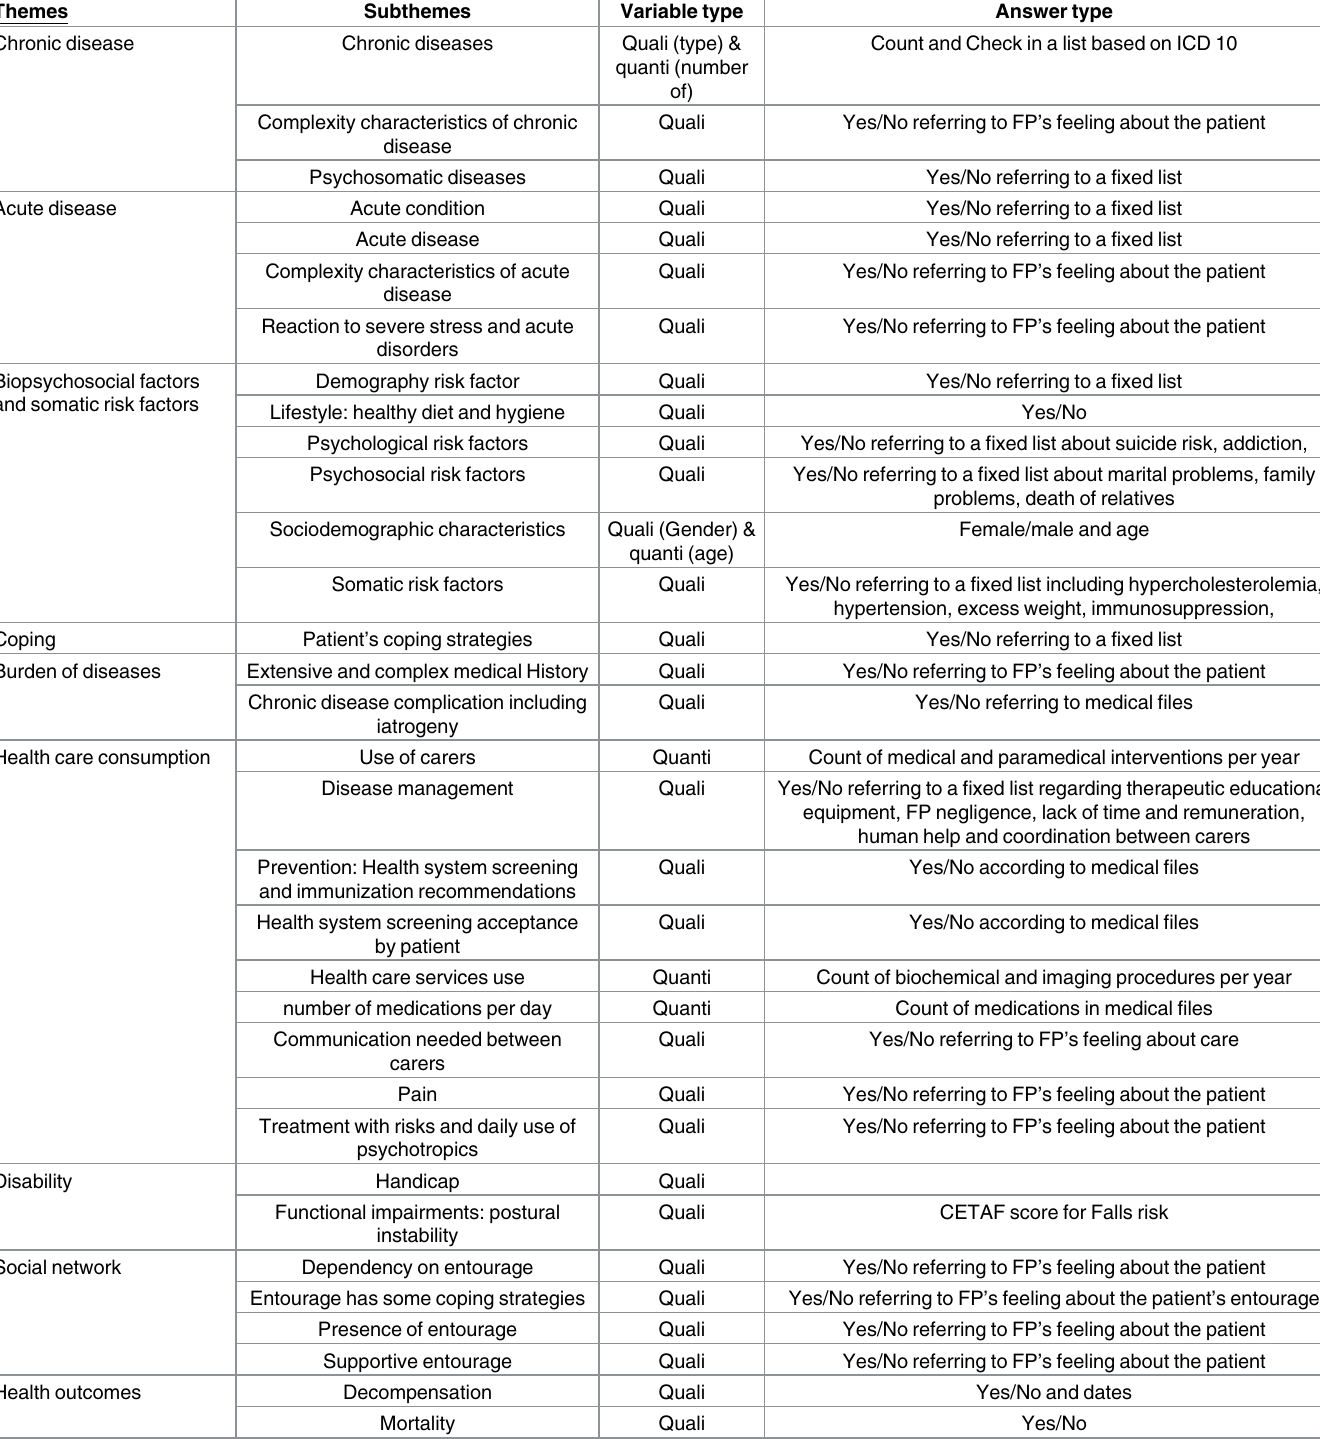
Table 1. Themes and type of related variables identified for multimorbidity conditions. All variableswere reportedby physicians and then double- checked in medicalfiles by the research team with the exceptionof those which reportedFPs’